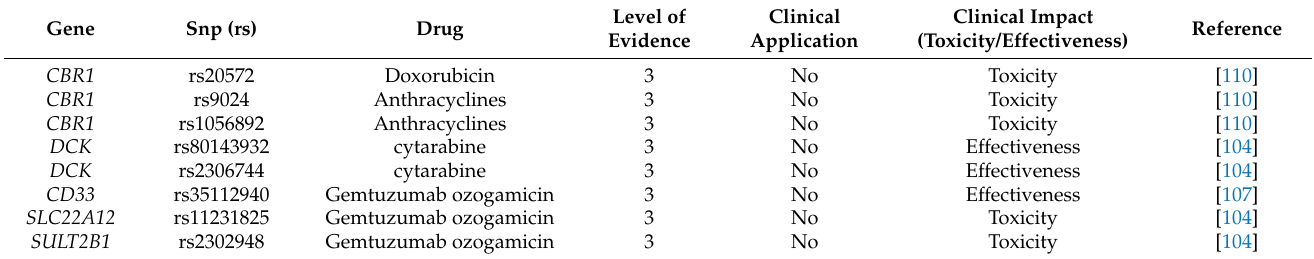
Table 6. Summary of Major Genetic Polymorphisms and their clinical impact in AML.